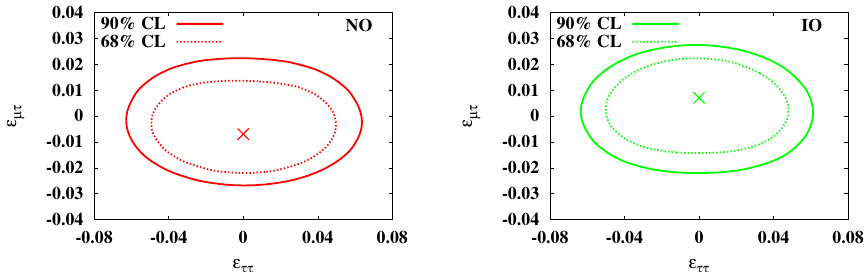
Figure 4 . Allowed regions for the parameters (cid:15) (cid:22)(cid:28) and (cid:15) (cid:28)(cid:28) for NO (left panel) and IO (right panel). Other parameters (cid:15) (cid:11)(cid:12) of the matter NSI are set to zero. parameter allowed ranges at 90%